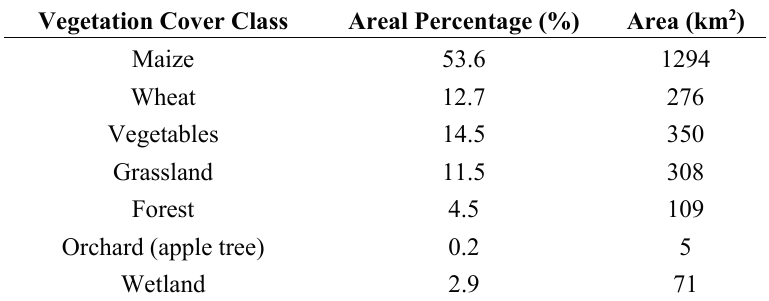
Figure 1. Land cover map of the middle reach of the Heihe River Basin in 2012. Table 1. The fractional abundances of the main vegetation classes over the study area resulting from the classification in Figure